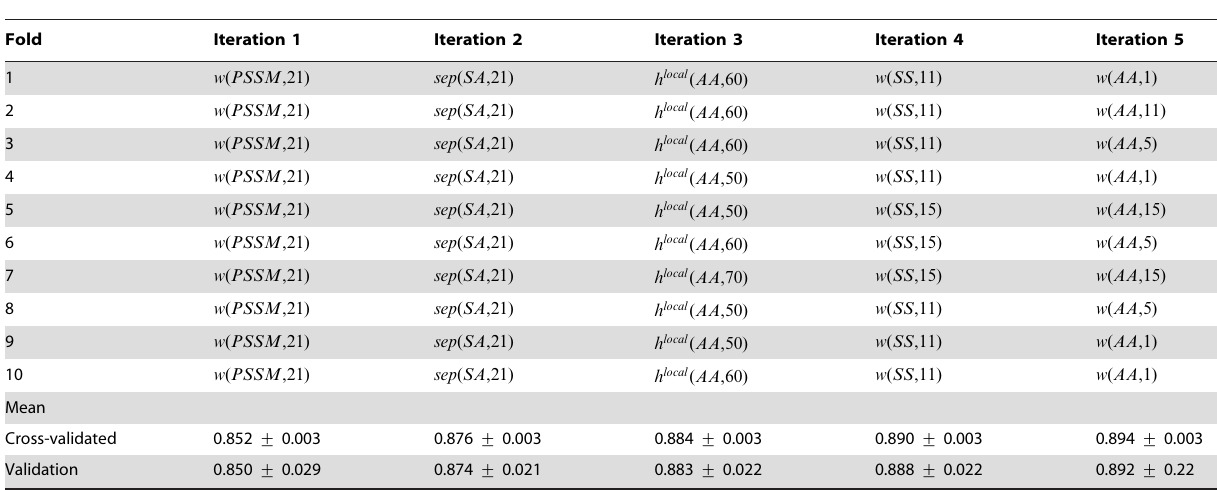
Table 3. Forward feature functions selection with 10 train/test